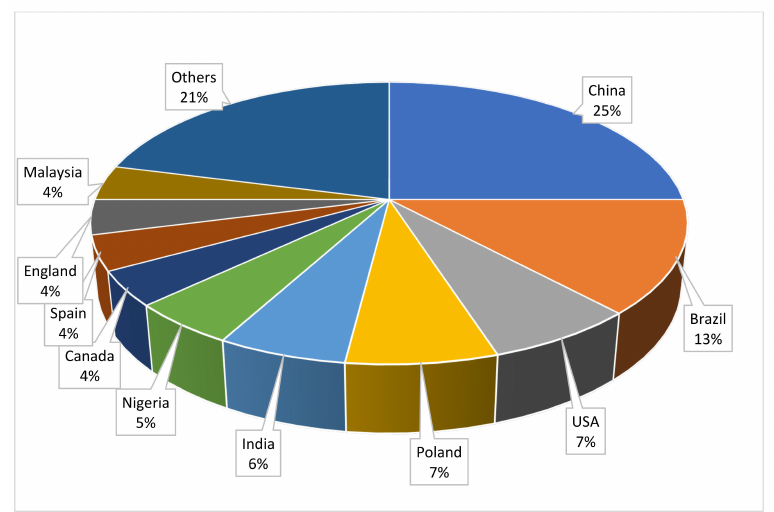
Figure 2. Share of publications on biomass briquetting by the location of authors (2012–2021).